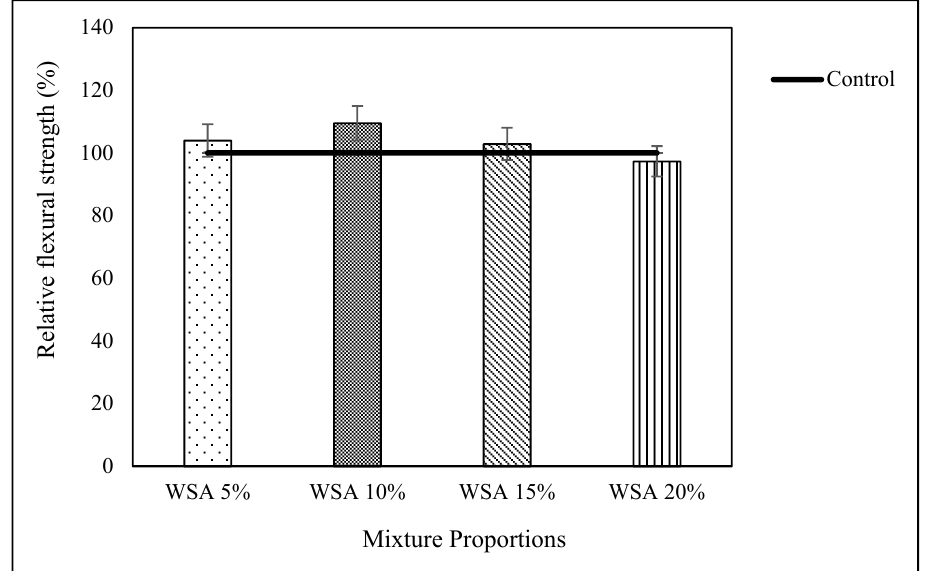
Figure 6. Relative flexural strength of concrete containing wheat straw ash.